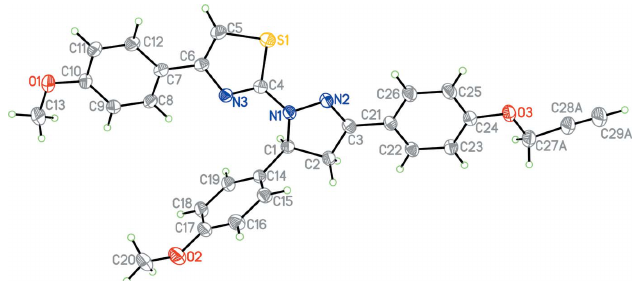
Figure 1 The major occupancy component of the title compound with atom labeling. Atomic displacement parameters are drawn at the 30% probability